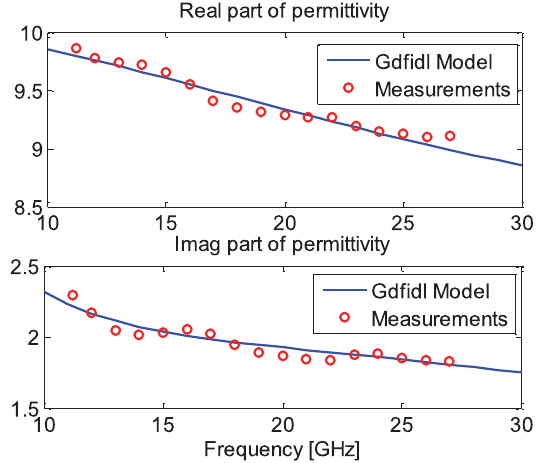
FIG. 18. Material properties of the HOM damping load.